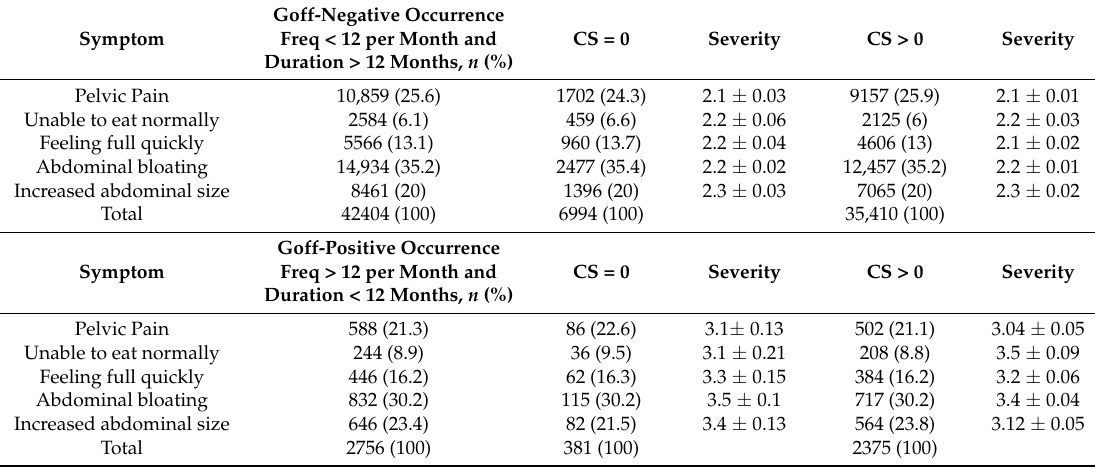
Table 7. Occurrence of symptoms related to ovarian cancer.